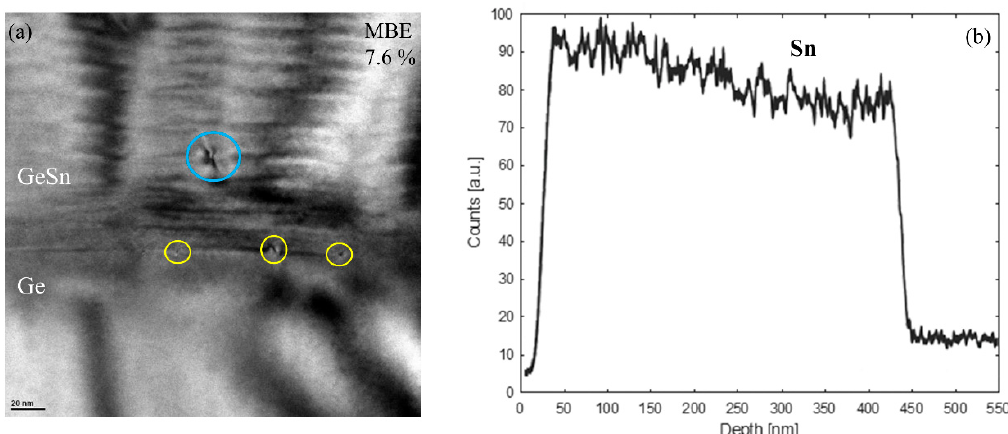
Figure 4. ( a ) XTEM and ( b ) the energy dispersive spectroscopy (EDX) of the GeSn sample with the Sn concentration of 7.6% grown by MBE. The EDX is collected from the surface of GeSn layer down to the Ge layer.